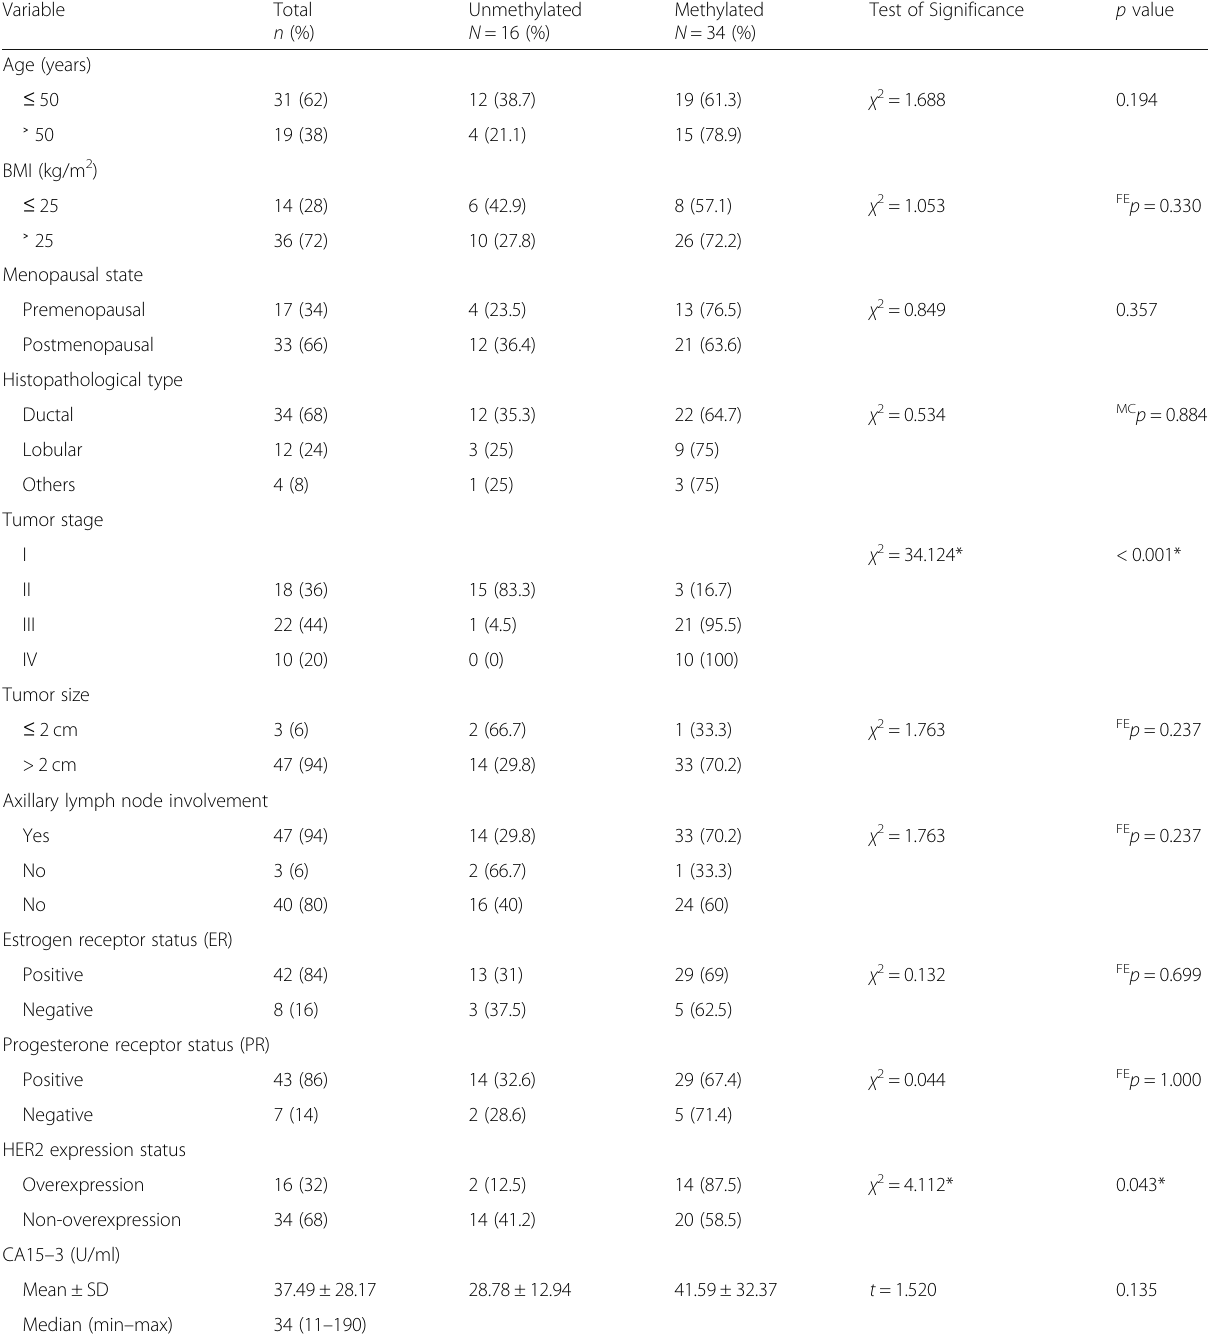
Table 1 Correlation analysis of YAP1 promoter methylation with different variables Variable Total